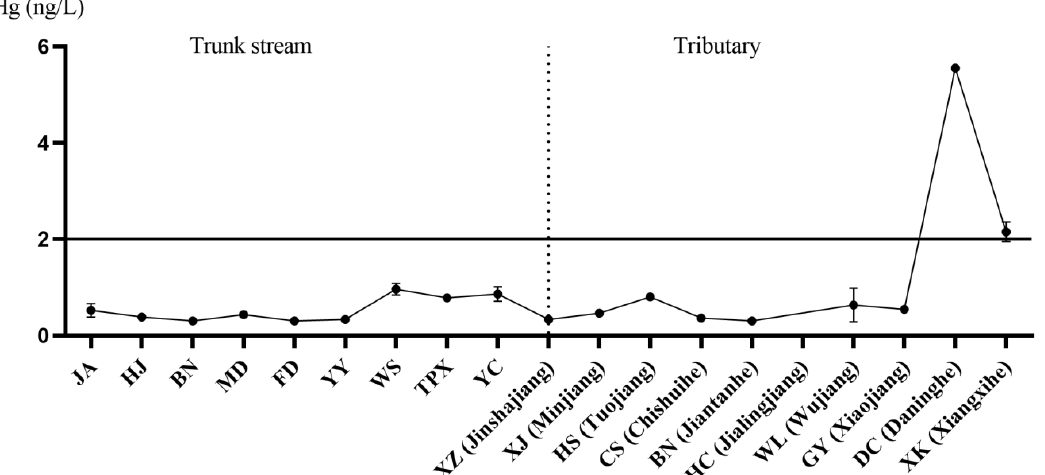
Figure 5. Spatial variance of Hg (ng/L) concentrations in the sampling stations of the Yangtze River. The horizontal and solid lines in the figure represent the background values in historical documents. The x-axis is the sampling point. The left side of the vertical dotted line is the main stream and the right side is the tributaries of the Yangtze River. The y-axis is the element concentration.